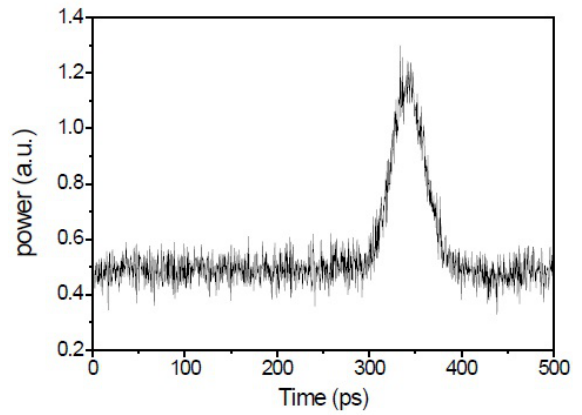
Fig. 20. Amplifcation of a telecom probe. A temporal trace recorded by a fast photo-detector in the telecom band. The instantaneous amplification after propagating through the silicon waveguide vis- ible (shown in the inset of Figure 18) of the telecom probe signal is clearly